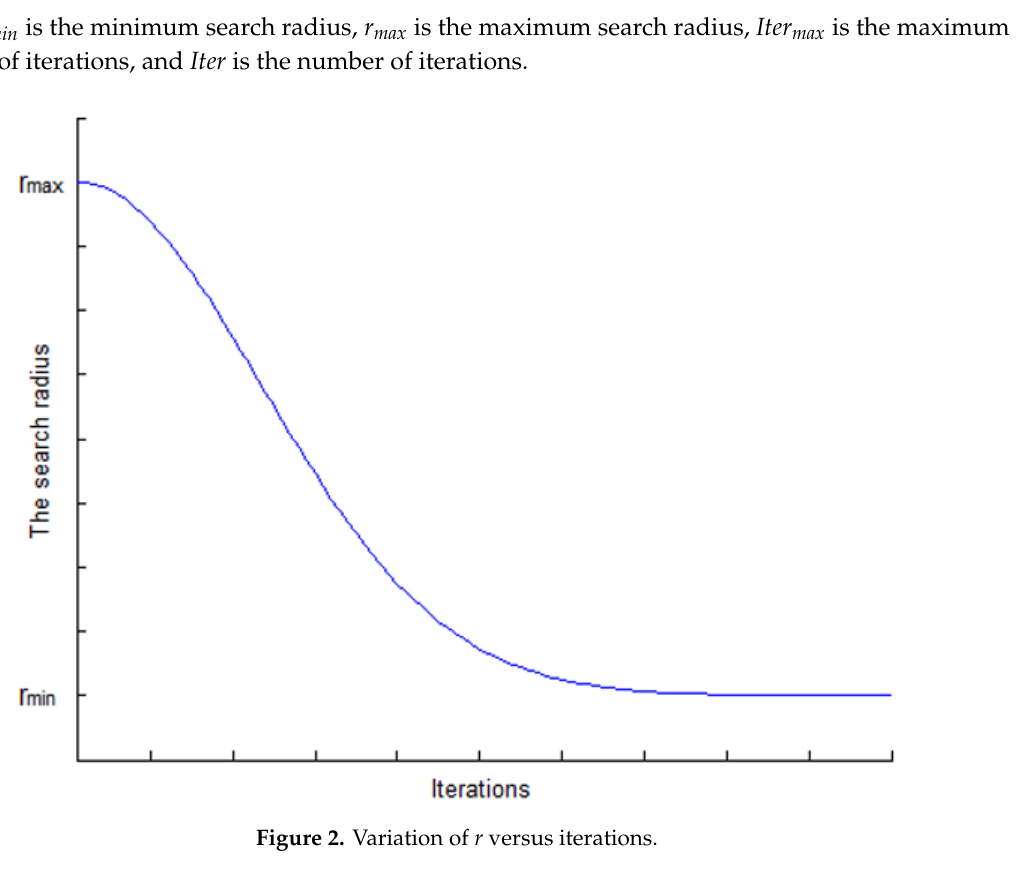
Algorithm 1 . Improved fruit fly optimization algorithm (IFOA) algorithm